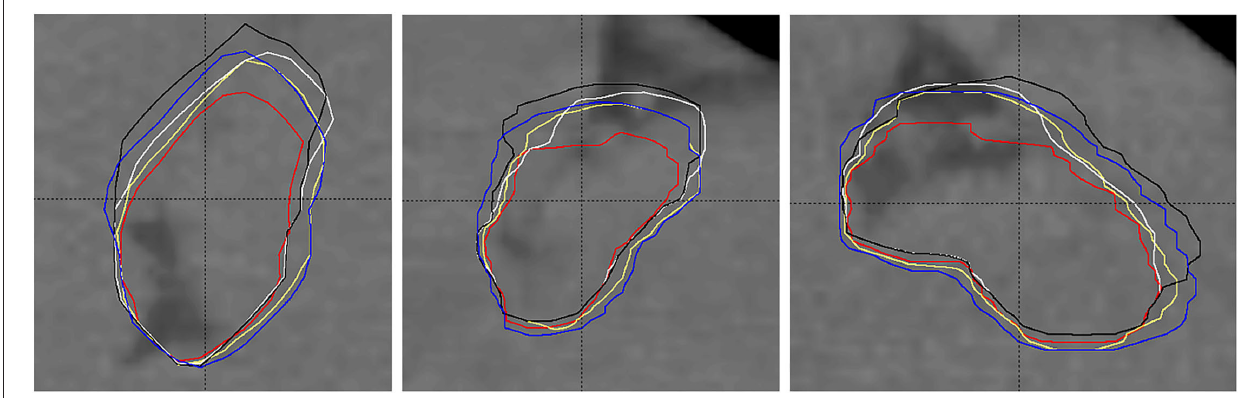
FIGURE 5 | Example of planning target volumes: original treated PTV (red, smallest), PTV GDM (blue), PTV GDM − SUM (yellow), PTV MIM (white), and PTV VELO (black). 1) RefSTRUCT (LMCA) on background CT image used as target surrogate, 2) anisotropic extension of the original target toward inspiration, 3) lesser differences among GDM- and DIR-based volumes than their difference to the original